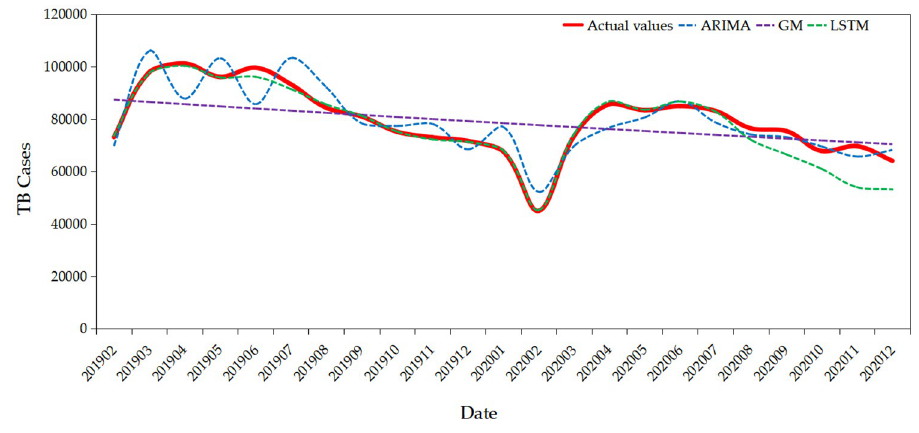
Fig 7. Plot of comparison of predicted values and actual values of three models.